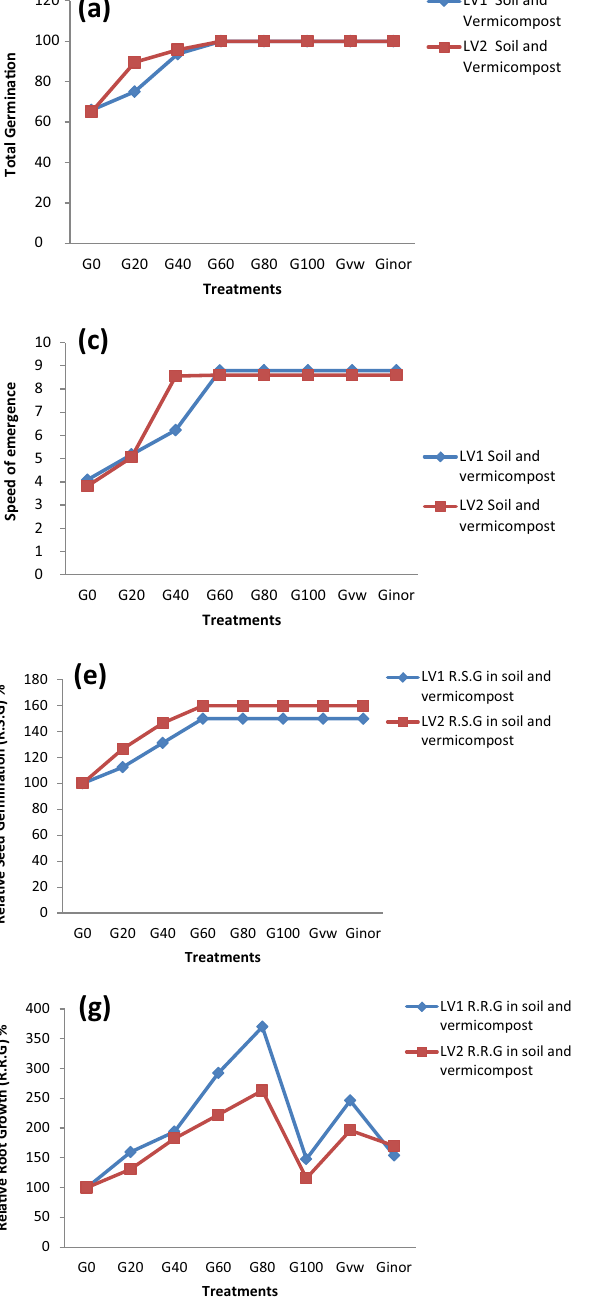
G ; G and G ; G and G . Results indicated CM40 60 CM60 vw CMvw that the role of vermiwash and vermicompost as potting media can be no less than commercial potting media. Scope of vermicompost to be used as an alternative to commercial potting substrates or peat is indicated in pre- sent study of germination indices. Vermicompost and G ; G and 20 CM20 40